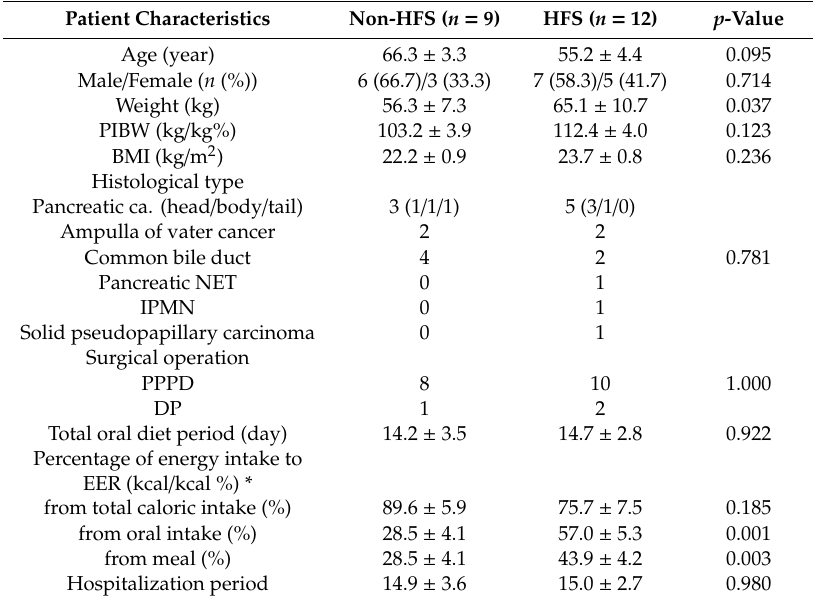
Table 1. Comparison of baseline clinical characteristics and energy intake during hospital stay between non-HFS and HFS